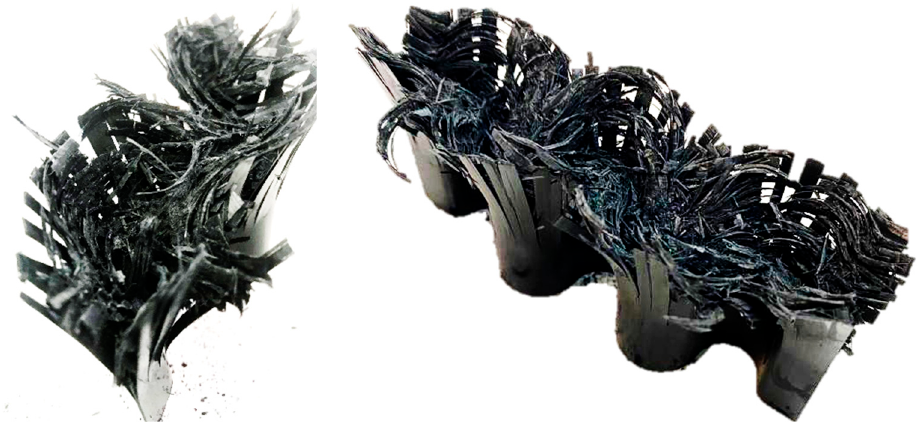
Figure 10. The deformed shapes of the sinusoidal specimens with 3 ( left ) and 5 curvatures ( right ).